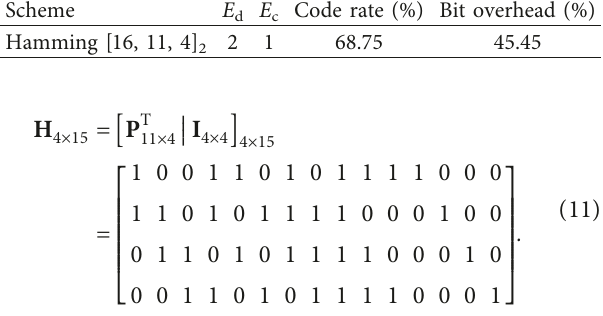
Table 7: Calculated performance aspects of Hamming [16, 11, 4].